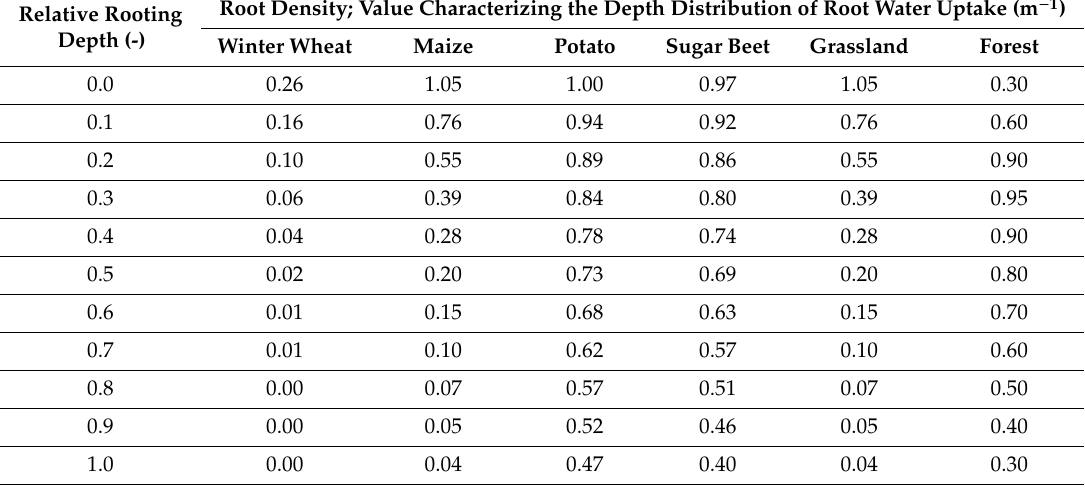
Table 3. Relative rooting depths and root densities of di ff erent crops [55].